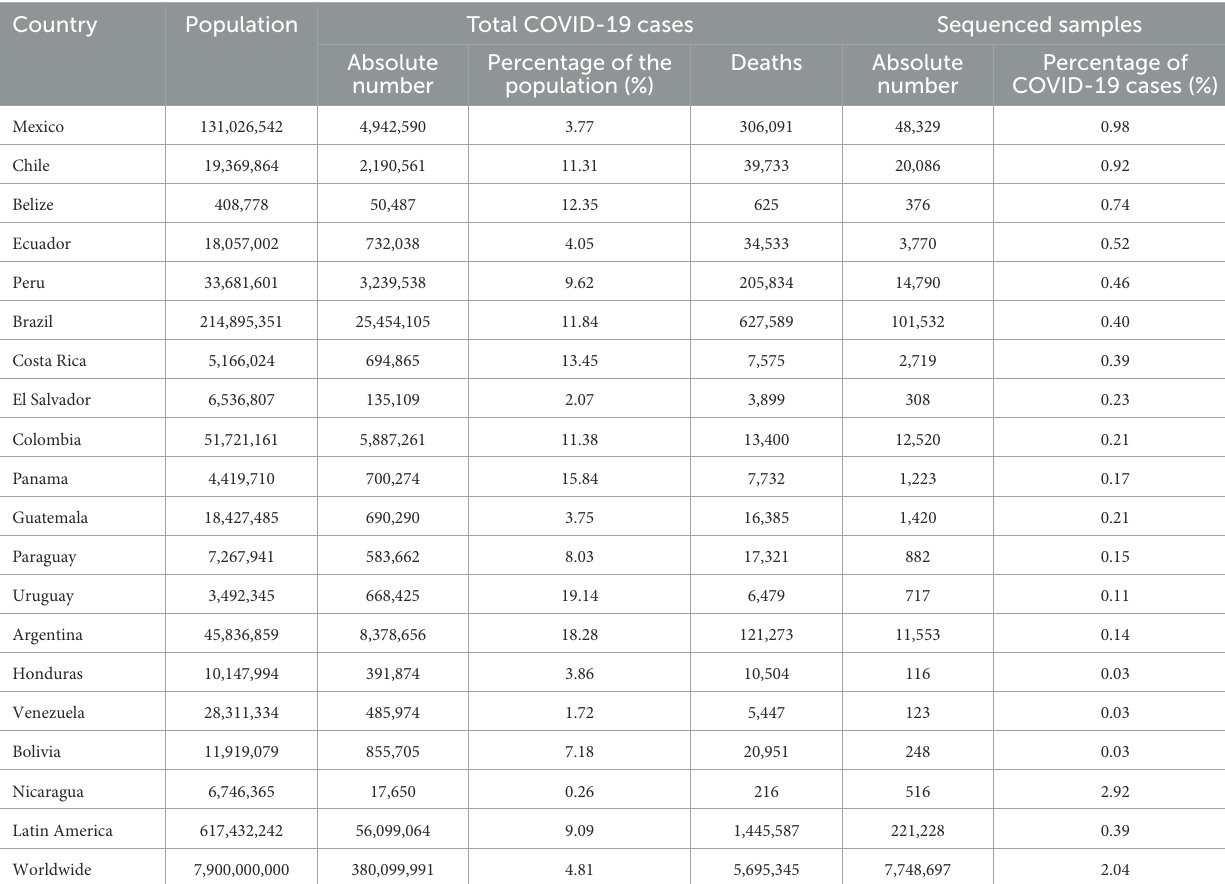
TABLE 2 Comparison of COVID-19 cases and sequenced samples among Latin American countries from the beginning of the pandemic to January 31th, 2022. Country Population Total COVID-19 cases Sequenced samples